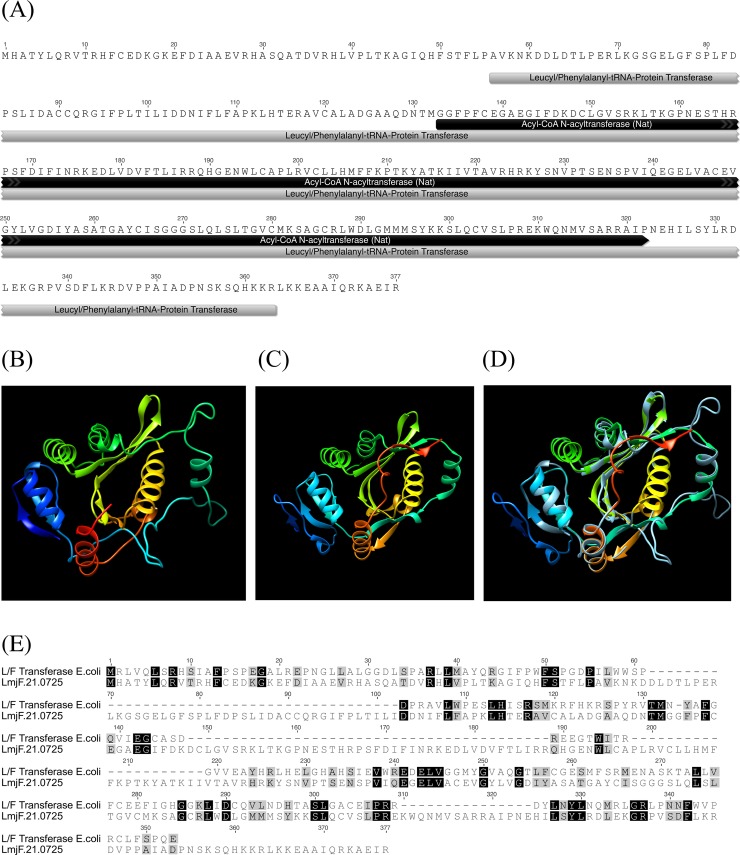
(A) PANTHER classification system categorizing LmjF.21.0725 as L/F transferase; InterProScan results showing the signature motif acyl-CoA-N-acyltransferase (NAT) and the predicted amino acid sequence of LmjF.21.0725. (B) Three-dimensional structure of LmjF21.0725 predicted by the Phyre2 server. (C) Template c2cxA (L/F transferase from E. coli) (D) Superimposed modeled structure of LmjF21.0725 with template c2cxA (E) Amino-acid sequence alignment between LmjF21.0725 and L/F transferase from E. coli.